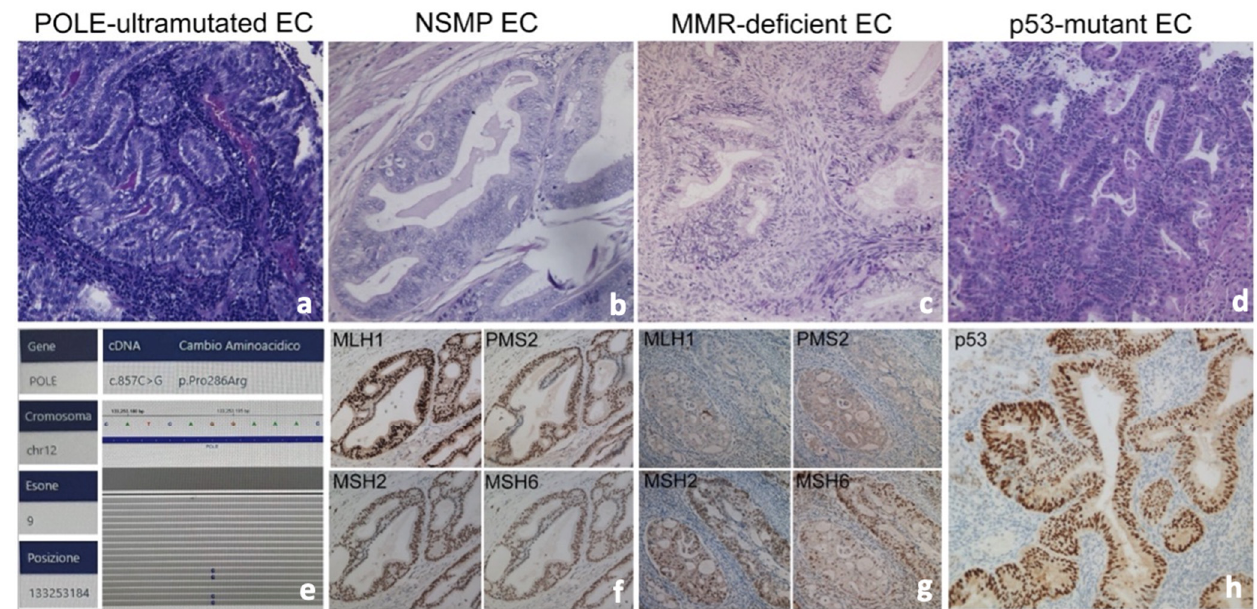
Figure 2. Histological sections of endometrioid carcinoma and typical features of molecular sub- groups ( a – d ), Hematoxilyn-Eosin 20 × ): POLE-EC ( a , e ), NSMP-EC ( a ) mismatch repair-proficient (( f ), immunostains), MMR-deficient EC ( c ) with absence of expression of MLH1 and PMS2 (( g ), immunostains), p53-EC ( d ) with abnormal diffuse nuclear overexpression of p53 associated with TP53 mutation (( h ), immunostains).